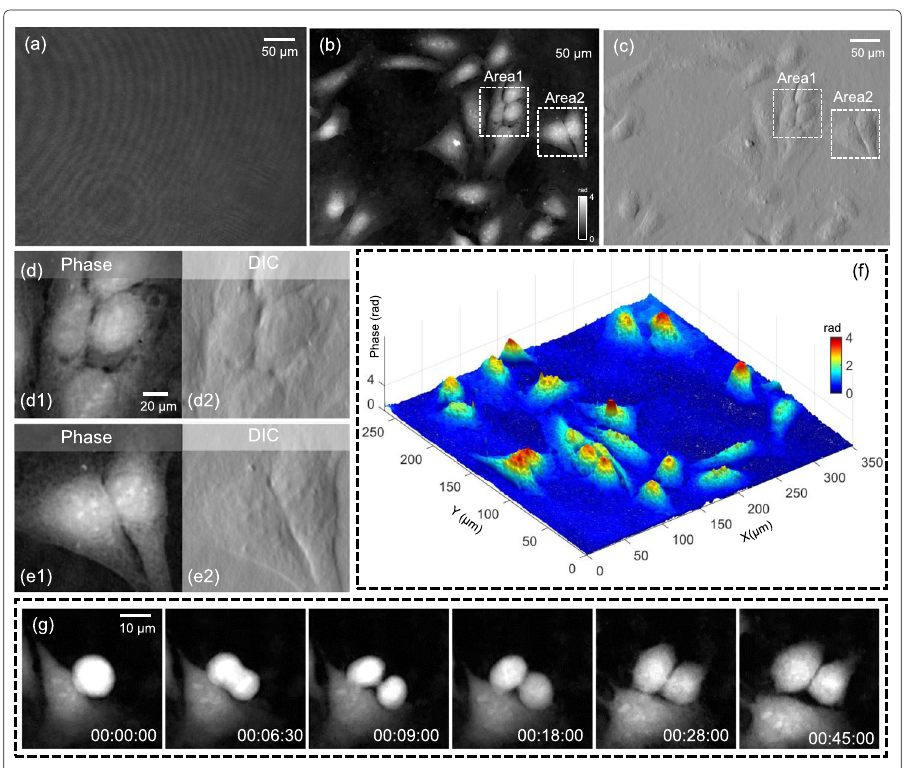
Fig. 10 Quantitative phase of HeLa (human cervical cancer) cells. (a) A recorded hologram. (b) Quantitative phase reconstructed by DH-SCLM. (c) Phase gradient images generated from quantitative phase by digital DIC method. (d1), (e1) The sub-regions of interest of quantitative phase in (b). (d2), (e2) The sub-regions of interest of phase gradient images in (c). (f) 3D pseudo-color rendering image of the reconstructed quantitative phase. (g) The time-lapse video of dynamic division of HeLa cells in